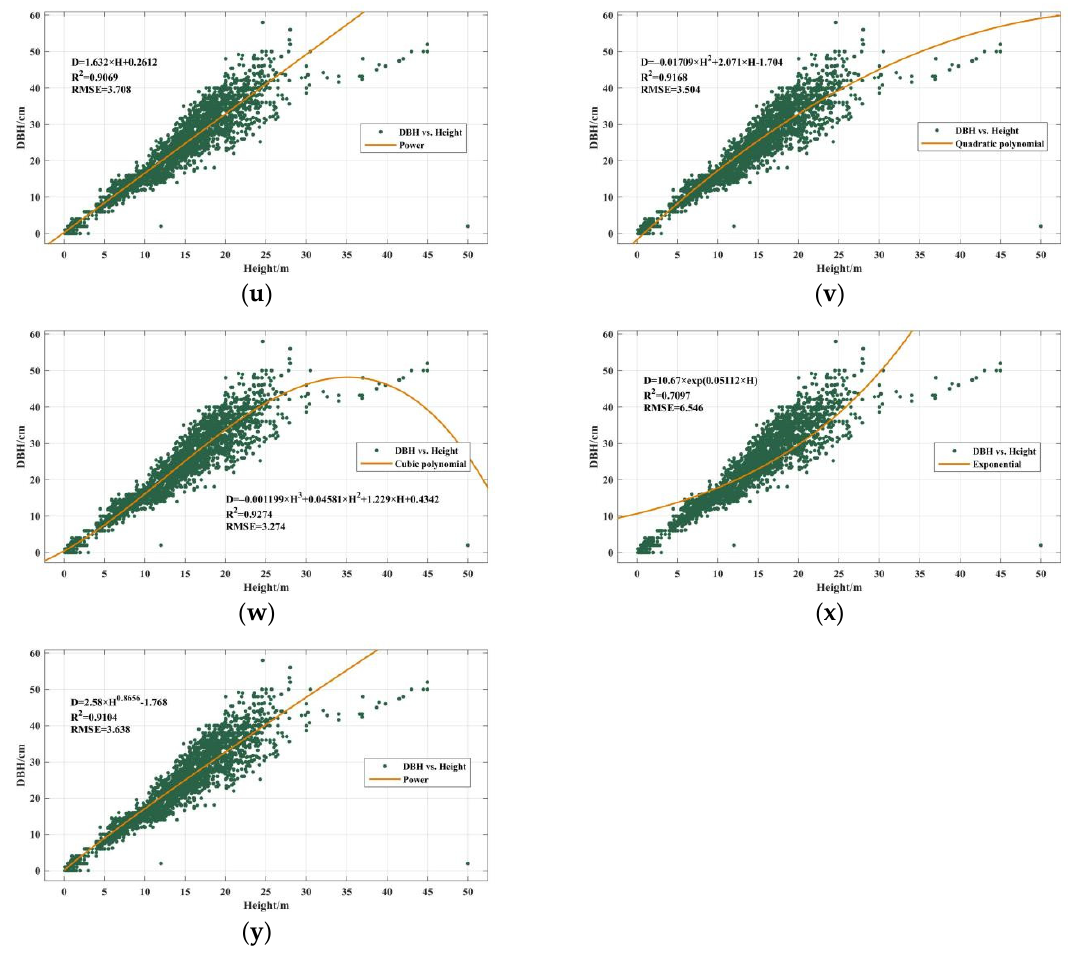
Figure 8. Regression models for tree DBH prediction from the tree Height including: linear model, quadratic-polynomial model, cubic-polynomial model, exponential model and power-function model. ( a – e ): Pinus densata Mast .; ( f – j ): Abies fabri ( Mast .) Craib ; ( k – o ): Quercus ; ( p – t ): Pinus yunnanensis ; ( u – y ): Picea asperata Mast .